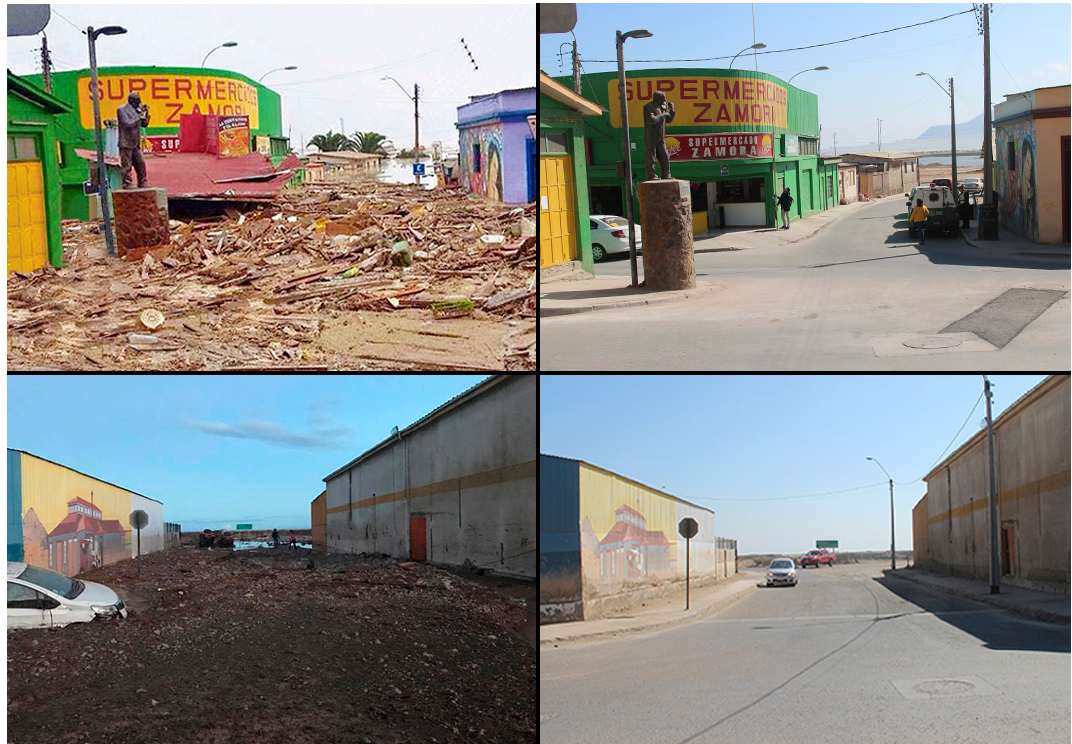
Figure 3. Comparison between the situation after the May 2017 floods ( left ), © Agencia Uno, and the current conditions in Chañaral in August 2017 ( right ), photos taken by the